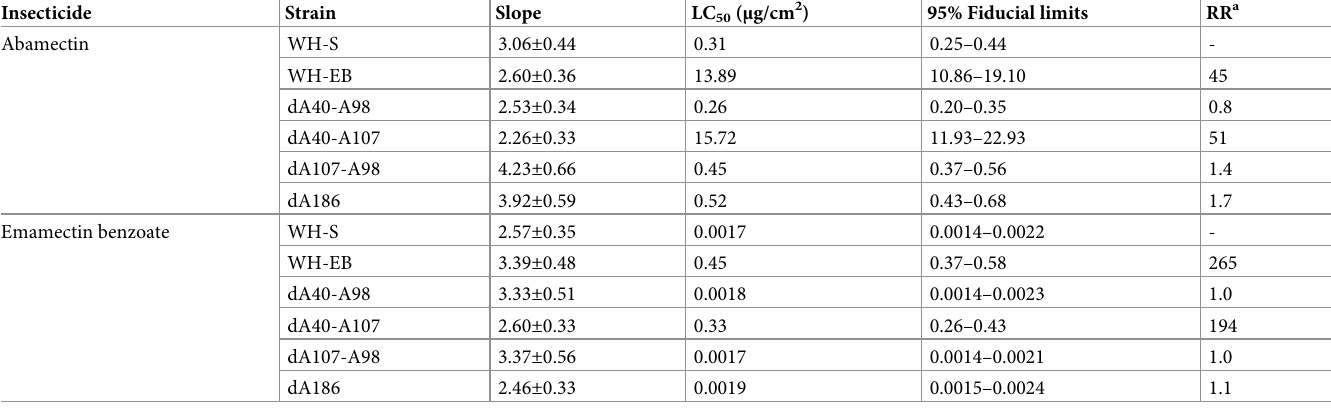
Table 3. Response to abamectin and emamectin benzoate of beet armyworm larvae from a susceptible strain (WH-S), a resistant strain (WH-EB), and four CRISPR/Cas9 gene-edited CYP9A knockout strains (dA40-A98, dA40-A107, dA107-A98, and dA186).